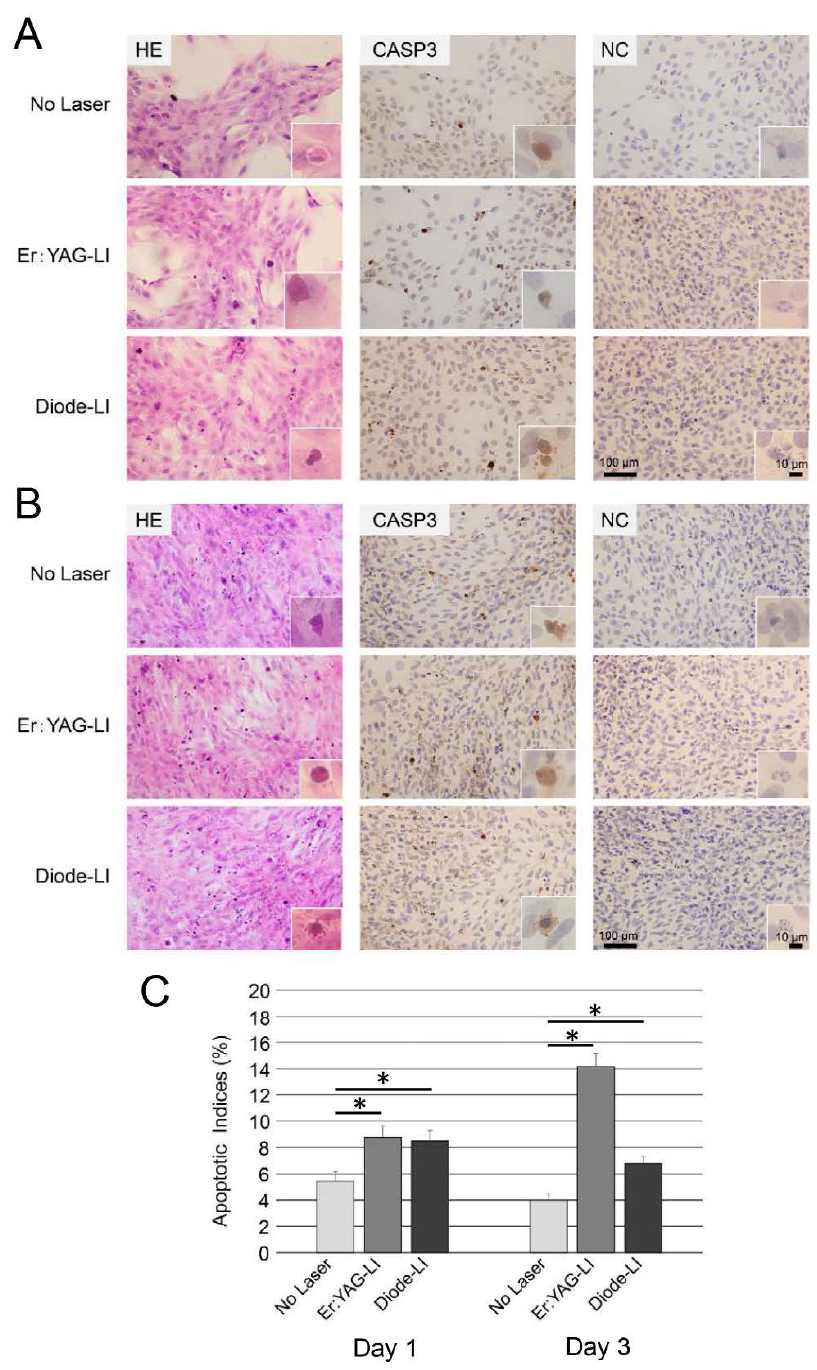
Figure 2. Effect of LI on apoptosis in PPU-7. Immunohistochemical detection of apoptosis in PPU-7 on ( A ) day 1 and ( B ) day 3 following LI. Eosinophilic apoptotic bodies in hematoxylin-eosin-stained PPU-7 detected by transmitted-light microscopy (HE) (magnification: 400 × ). Apoptotic bodies in PPU-7 stained by cleaved caspase-3 antibody (CASP3); the control was processed without primary antibody (NC). The images are high magnification of the area boxed in the Figure. ( C ) Apoptotic indices in PPU-7 with or without laser treatment. Each of the apoptotic indices was calculated as the percentage of the whole PPU-7 population. Values are the mean percentage ± standard error (* p < 0.01, Steel’s test). No Laser: control without LI.